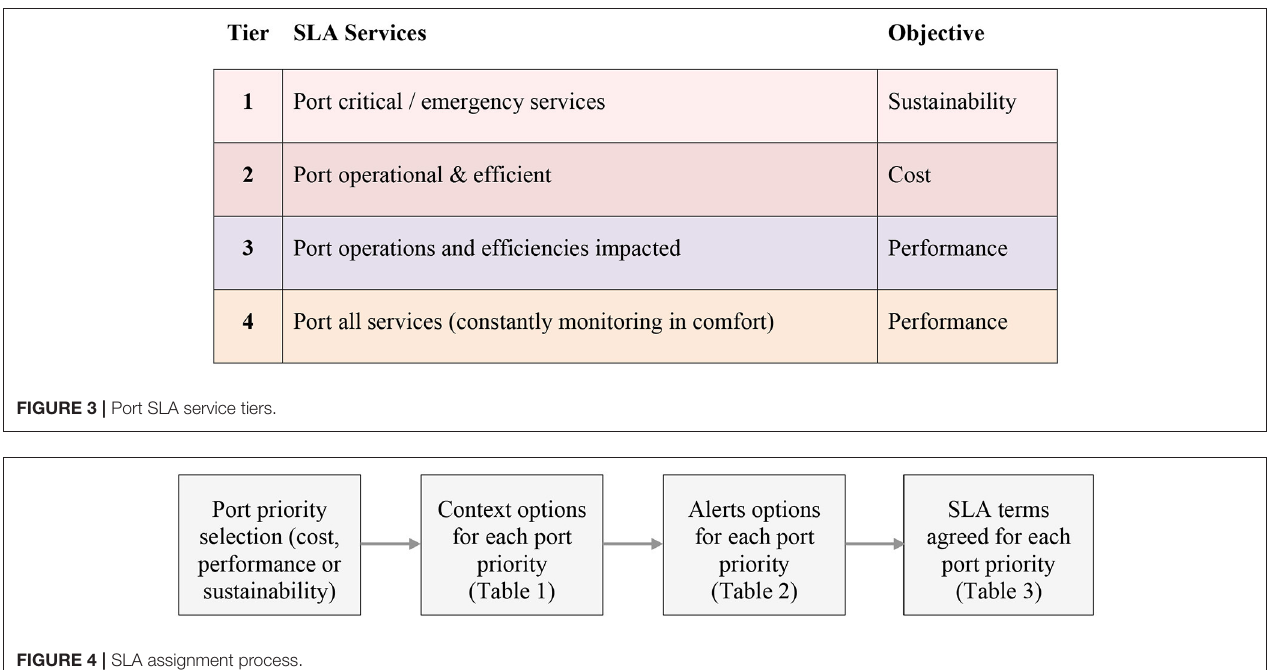
FIGURE 4 | SLA assignment